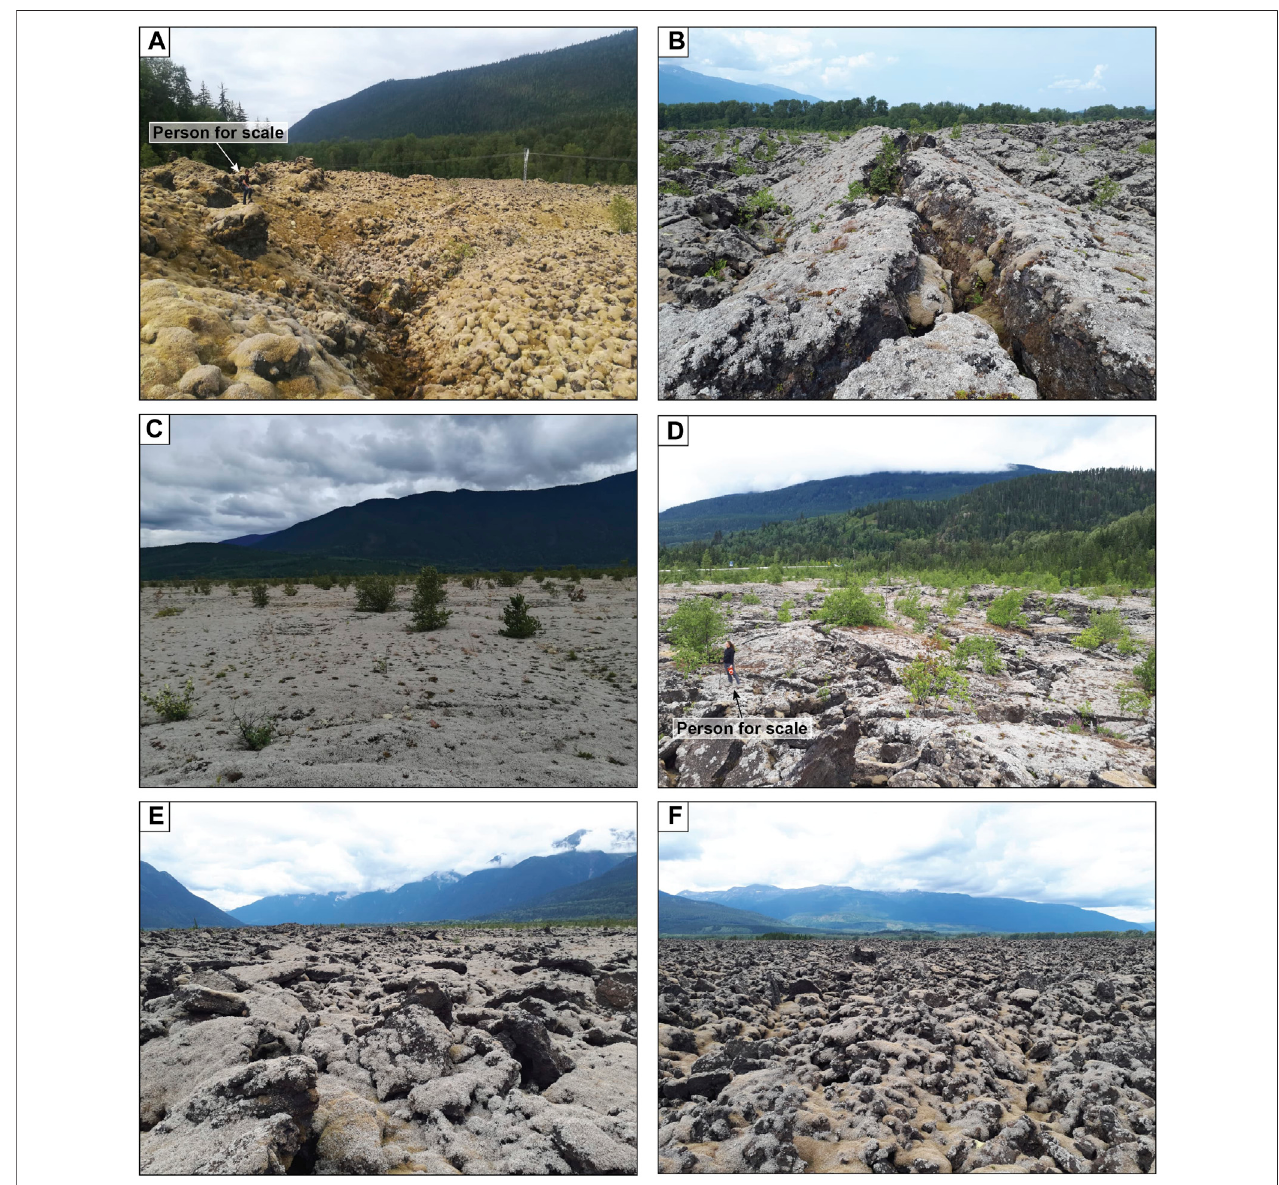
FIGURE 3 | Main Tseax lava fl ow surface morphologies. Note that the entire lava fl ow fi eld is covered by afew cm-thick layer of grey toyellowlichensand mosses. (A) “ A ” ā lava fl owat the bottom ofCrater Creek valley. (B) Hummocky p ā hoehoe. (C) Lava-rise. (D) Hummocky-to-lava-rise. (E) Slabby p ā hoehoe. (F) Slabby-to-rubbly p ā